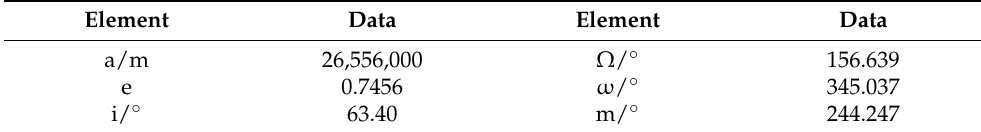
Table 2. Classical orbital elements of space debris from Molniya orbit. Element Data Element Data